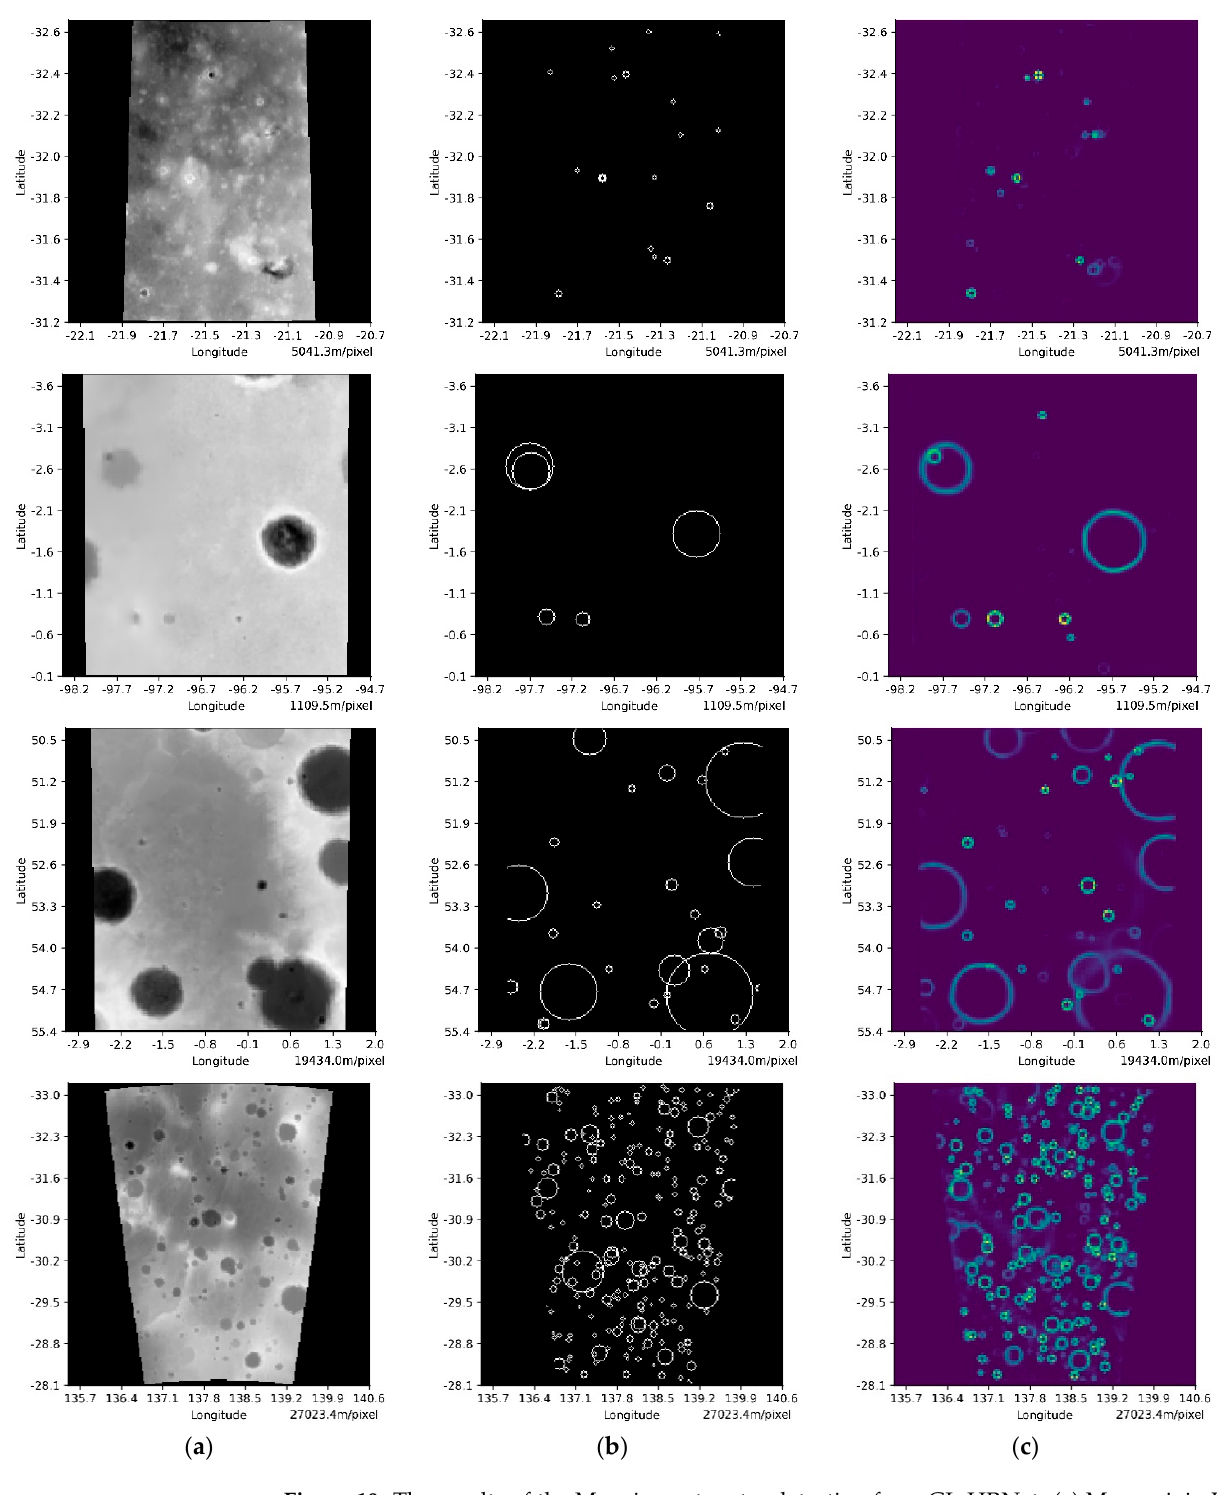
Figure 10. The results of the Mars impact crater detection from GL-HRNet. ( a ) Mars origin DEM. ( b ) Ground truth. ( c ) Prediction.